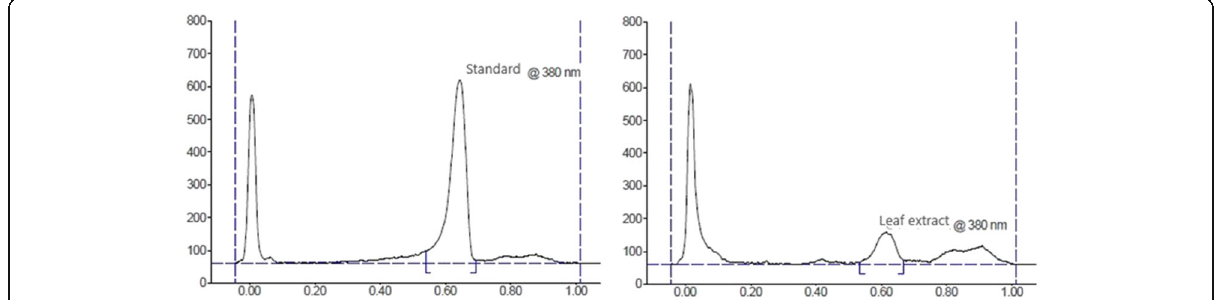
Fig. 7 HPTLC Densitogram of Standard (quercetin) and leaf extract Rf values are 0.64 and 0.62 at 380 nm